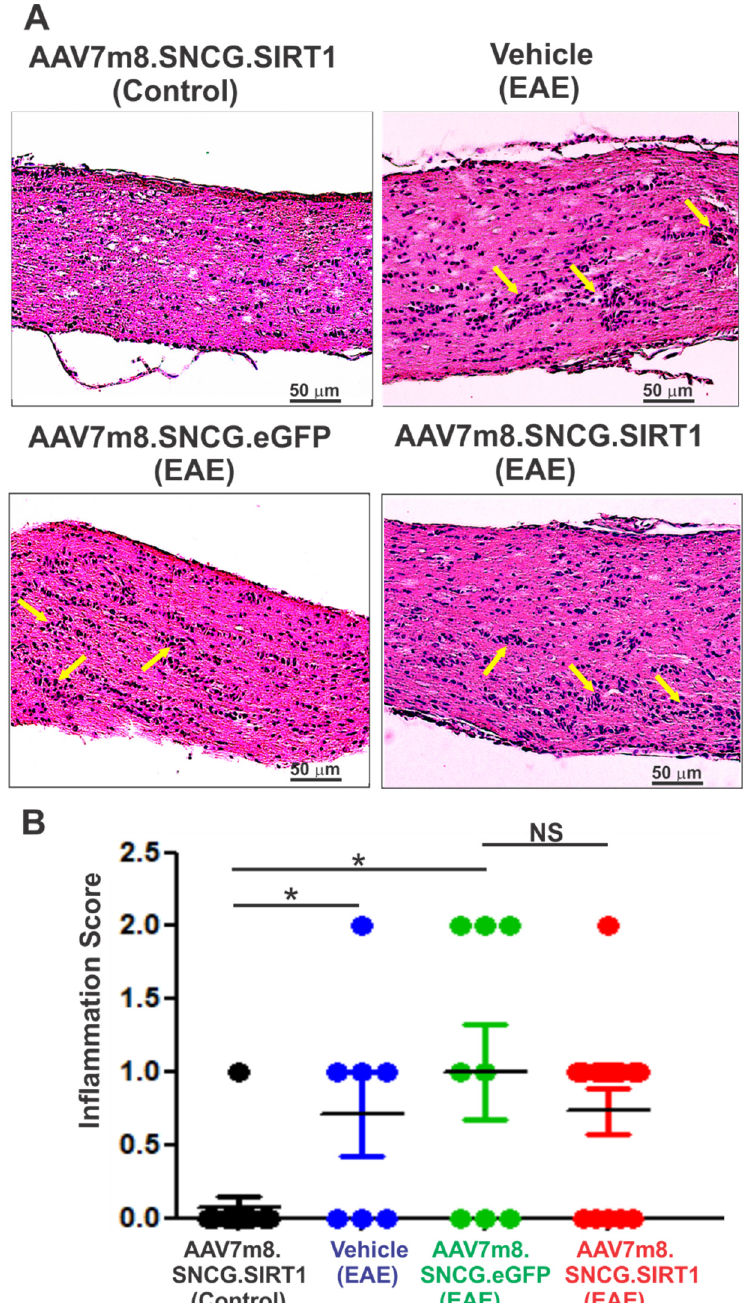
Figure 4. Effects of AAV7m8-mediated SIRT1 gene transfer in RGCs on optic nerve inflammation. ( A ) H&E staining of optic nerve longitudinal sections from vehicle-, AAV7m8.SNCG.eGFP- or AAV7m8.SNCG.SIRT1-treated mice are shown. Yellow arrows indicate small foci of inflammatory cell infiltrates in representative optic nerve photos. Optic nerve sections were imaged with 20 × objective lens. Scale bar, 50 µ m. ( B ) Inflammation scores determined by ratings of the number of infiltrating cell clusters. Data represented as mean ± SEM. * p < 0.05 by one-way ANOVA and Tukey’s multiple comparisons test ( n = 13 for AAV7m8.SNCG.SIRT1 (control); n = 7 for vehicle (EAE); n = 8 for AAV7m8.SNCG.eGFP (EAE); n = 17 for AAV7m8.SNCG.SIRT1). NS = not